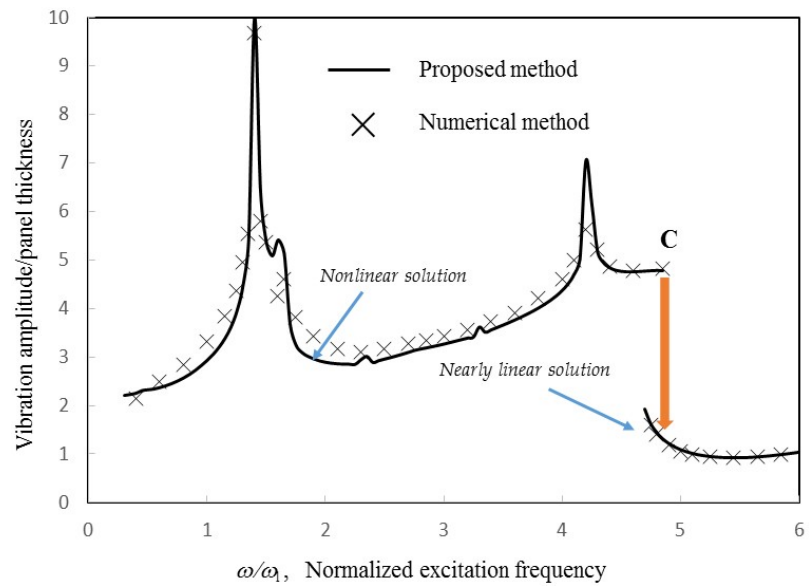
Figure 7. Comparison between the solutions obtained from the proposed method and numerical integration method [6] (number of structural modes = 2, number of acoustic modes = 4, l = 5 a , γ = 8, θ = 0; the orange arrow represents the “jump phenomenon”; “ C ” represents the particular point on the solution curve).